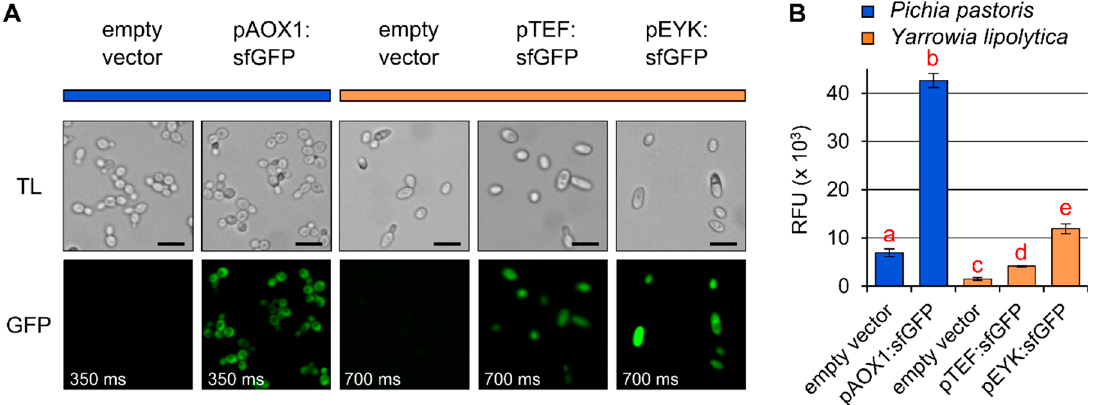
Figure 3. Comparison of fluorescent protein expression in two di ff erent yeast species. Pichia (blue) and Yarrowia (orange) cells after 24 h of growth in methanol- or erythritol-containing media (see Supplemental Materials and Methods), respectively, and expressing no transgene (empty vector) or sfGFP under control of the methanol-inducible pAOX1 , the constitutive pTEF , or the erythritol-inducible promoter pEYK . ( A ) Widefield micrographs of transmitted light (TL) and GFP signals in yeast cells after exposure (time indicated in each panel) to a halogen light source. Scale bars = 10 µ m. ( B ) Relative fluorescence units (RFU; normalized to optical density at 600 nm) of yeast cells quantified with a plate reader. Di ff erent letters indicate significant changes based on one-way ANOVA with post hoc Tukey HSD Test ( P < 0.05). Data show mean ± SD of three biological replicates.